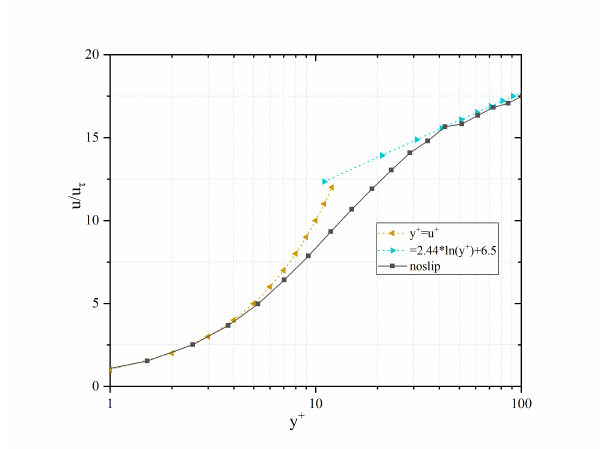
(cid:0) (cid:1) + y + 6.5 in